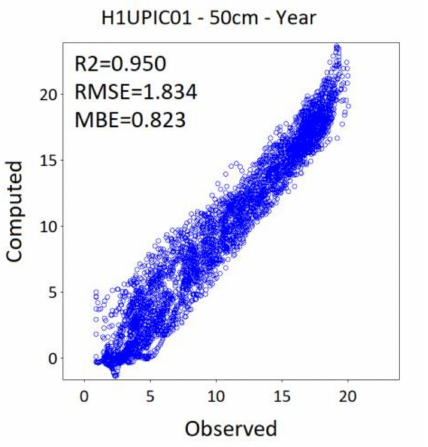
Figure A8. Validation at site H1UPIC01 for 50 cm soil